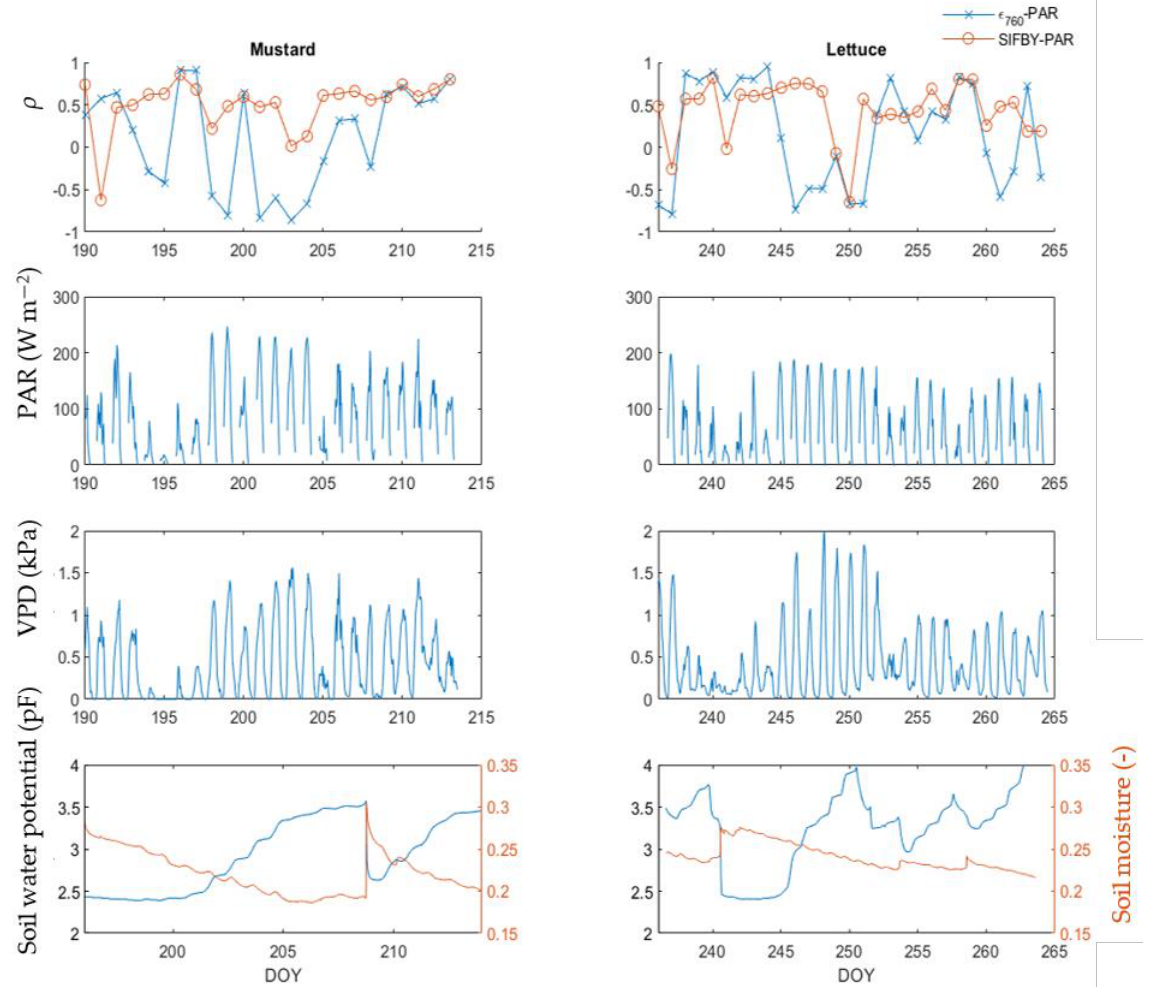
Figure 8. Daily correlation coefficient of ϵ 760 , SIFBY and FCVI to PAR for the mustard and lettuce experiments during their adult phases. Stress conditions are given by the a